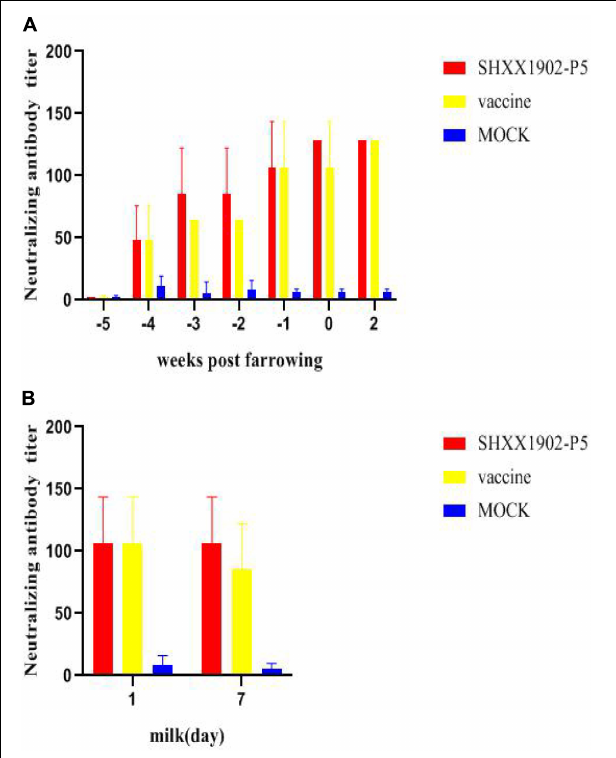
FIGURE 6 | Levels of neutralizing antibodies in the serum and the milk of sows after immunization with different strains. Levels of PEDV-specific neutralizing antibodies in the serum (A) and PEDV-specific neutralizing antibodies in the milk (B) were determined. All data are shown as means ± SD.